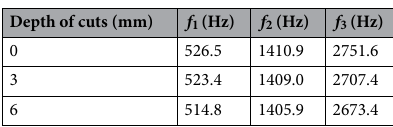
Table 2. Natural frequencies of the first 3 modes.